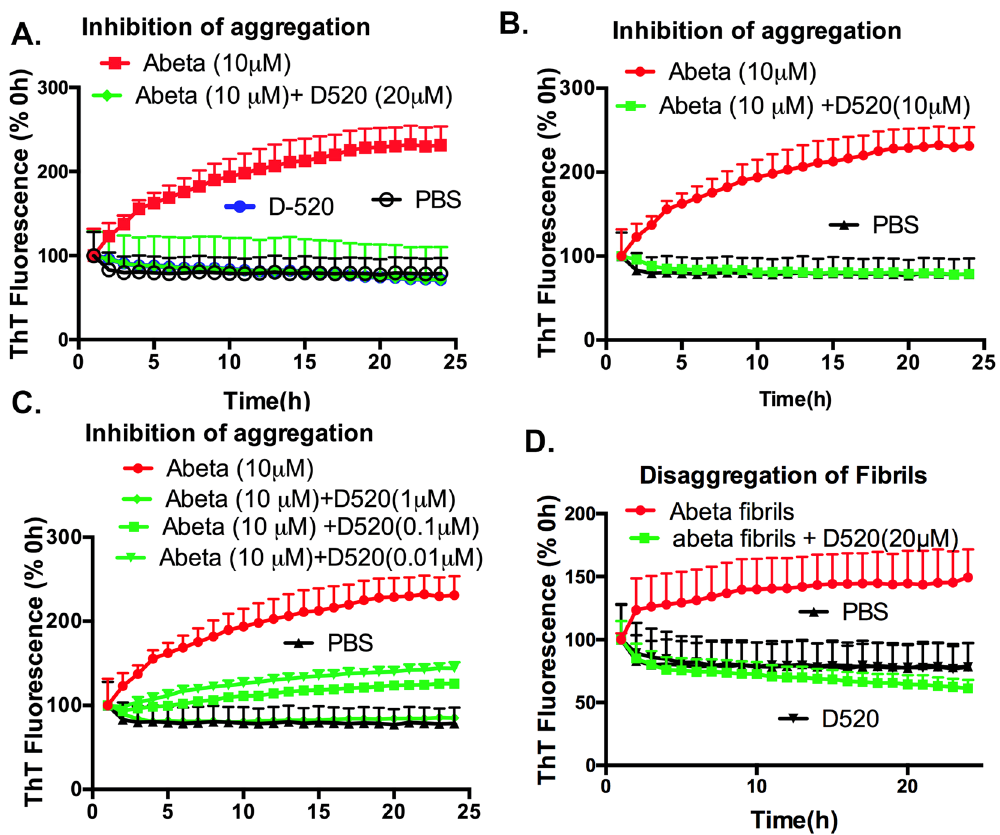
Figure 4. Kinetics on inhibition and dissociation of A β 1–42 oligomer formation by D-520: ( A – C ) ThT fluorescence of A β 1–42 (10 μ M) with or without incubation with either D-520 (20 μ M, Panel: A) or D-520 (10 μ M, Panel: B) or D-520 (1 or, 0.1 or 0.01 μ M, Panel: C) for 24 h. ( D ) ThT fluorescence of A β 1–42 fibrils (10 μ M) with or without incubation with D-520 (20 μ M) for 24 h. The ThT fluorescence of A β 1–42 at 0 h was considered as 100%. One-way ANOVA followed by Tukey’s multiple comparison post hoc test, **** P < 0.0001 comparing abeta to abeta + D520 (Panel A-C) and **** P < 0.0001 comparing abeta fibrils to abeta fibril + D520 (Panel